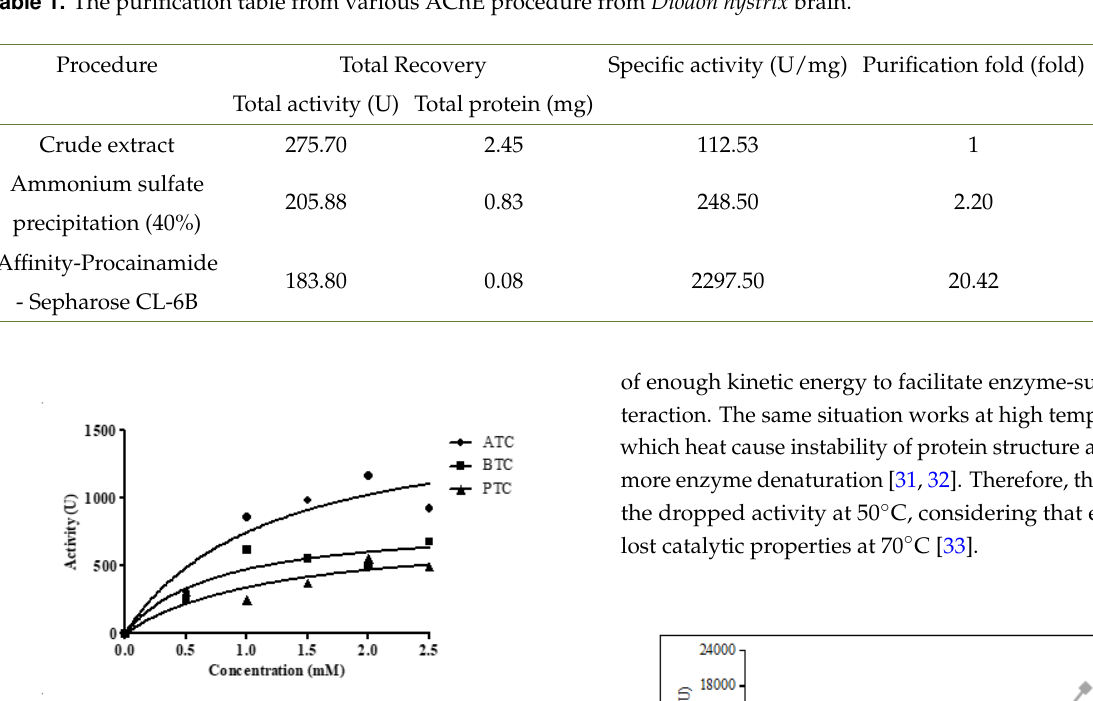
Table 1. The purification table from various AChE procedure from Diodon hystrix brain.